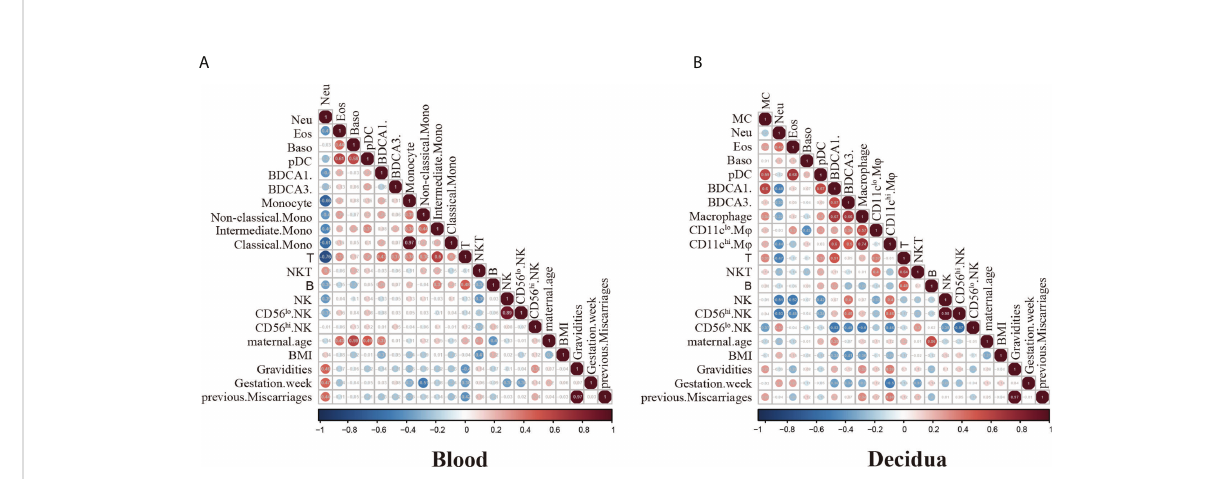
FIGURE 5 Spearman correlation analysis of immune cell frequencies and RPL patients ’ clinical features. (A) Heatmap visualization shows spearmen correlation coef fi cient for clinical features including maternal age, BMI, gravidities, gestation week, BMI, previous miscarriages and peripheral immune cell frequencies. Key indicates r value scale for positive (red) and negative (blue) correlations. (B) Heatmap visualization shows spearmen correlation coef fi cient for clinical features including maternal age, BMI, gravidities, gestation week, BMI, previous miscarriages and decidual immune cell frequencies. Key indicates r value scale for positive (red) and negative (blue)